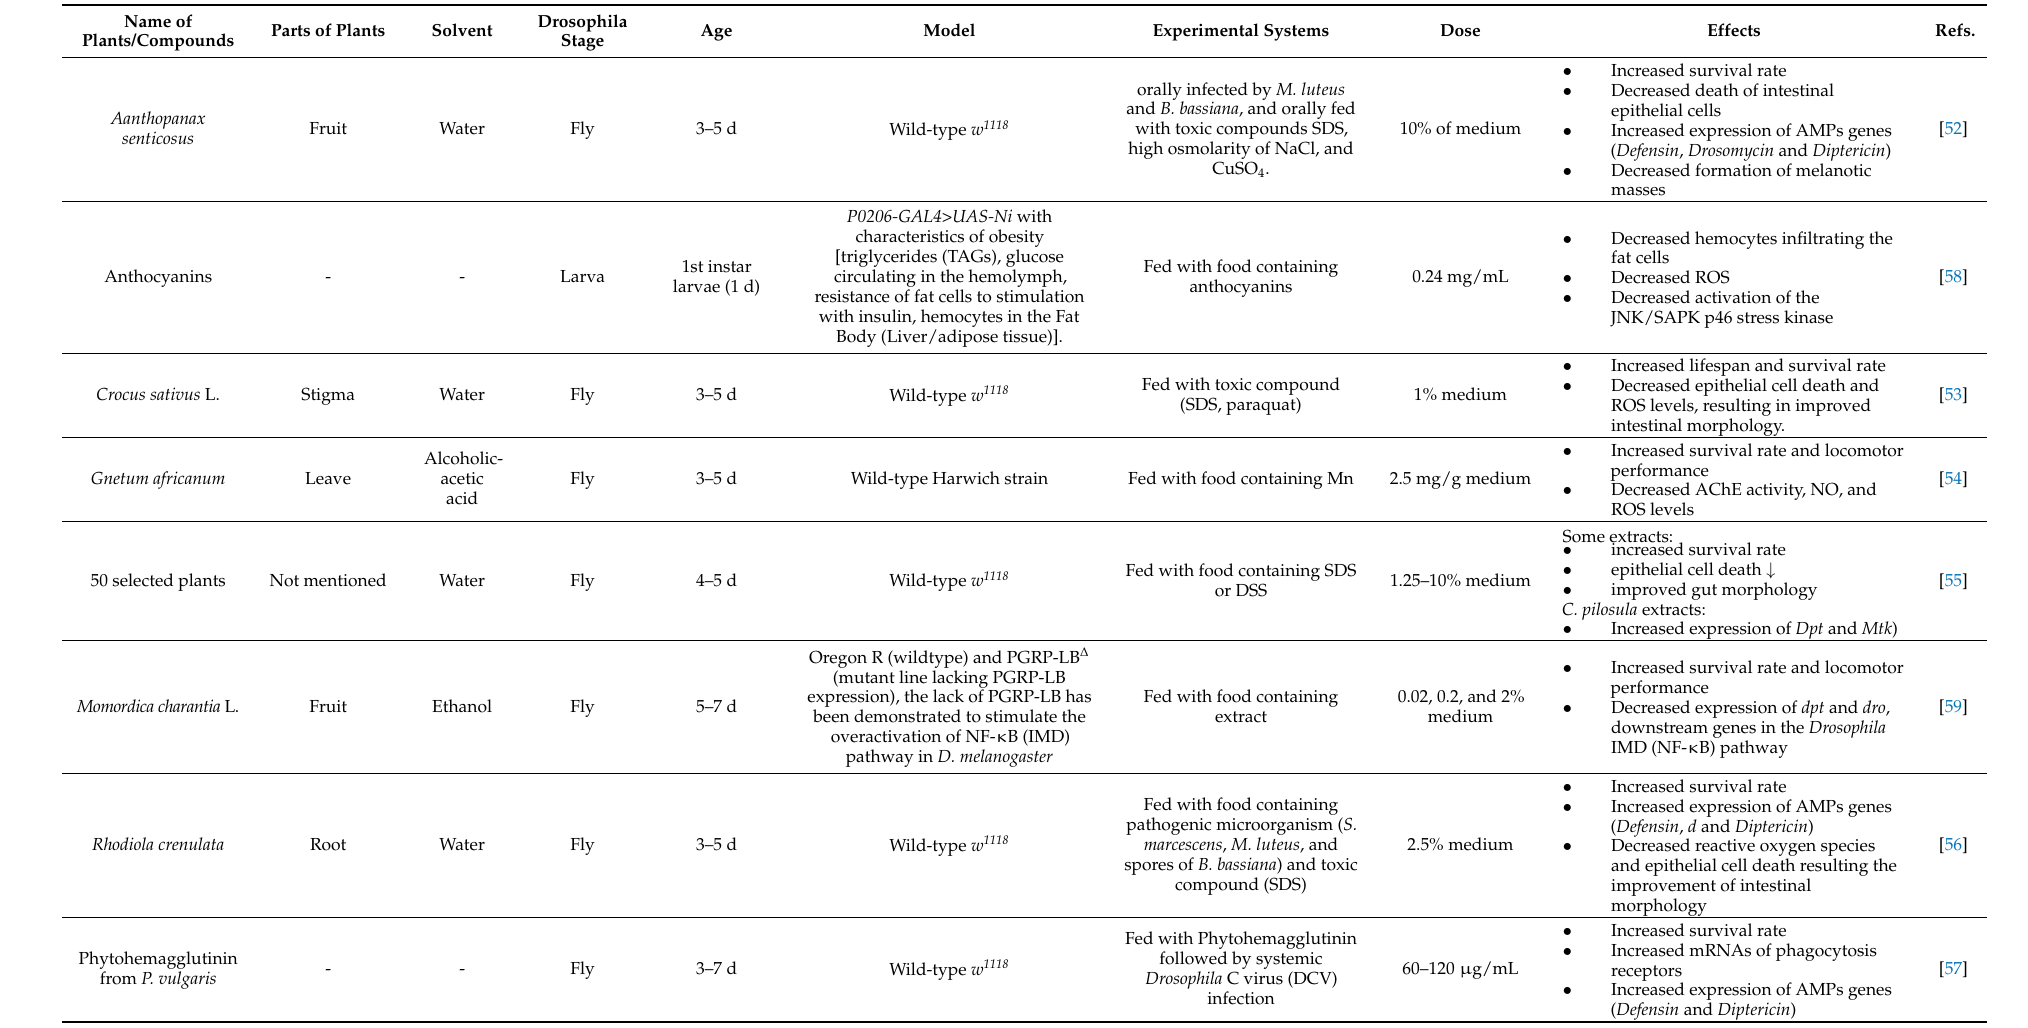
Table 1. Examples of immunomodulatory effects of plant/plant-derived compounds tested using the Drosophila